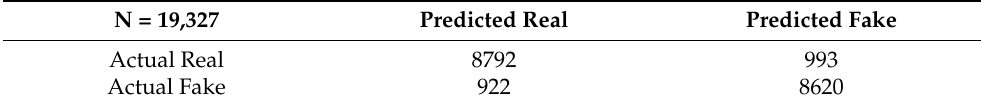
Table 6. Xception confusion matrix.